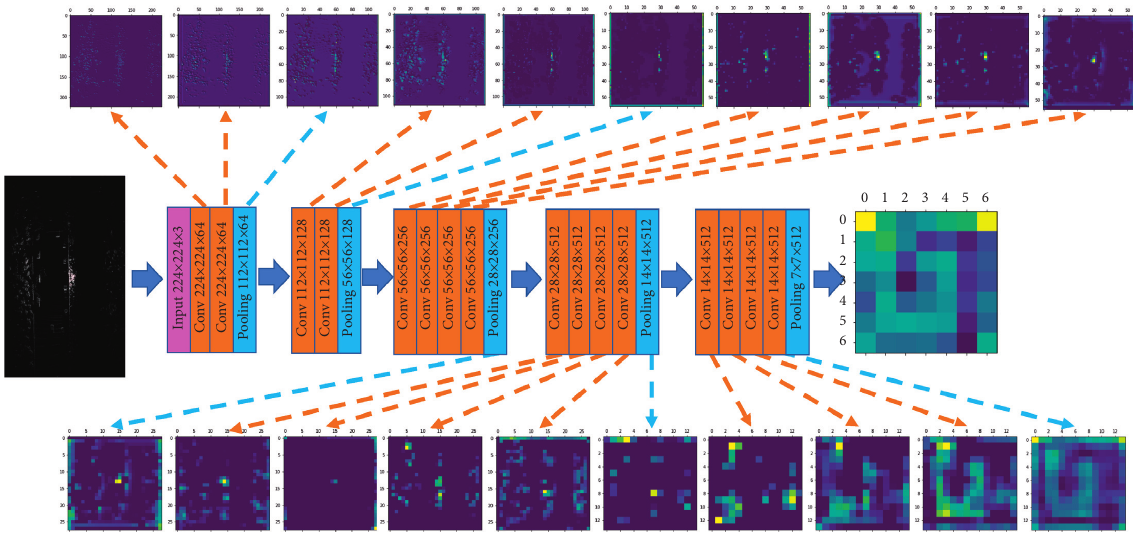
Figure 5: The process of the improved VGG19 network extracting feature map of point cloud top aerial view.